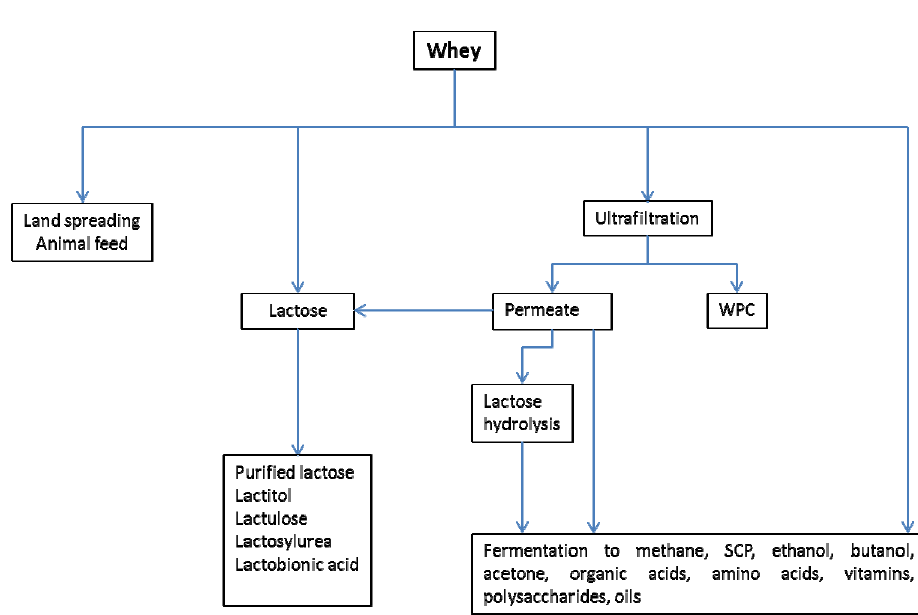
(SCP: Single cell protein and WPC: whey protein